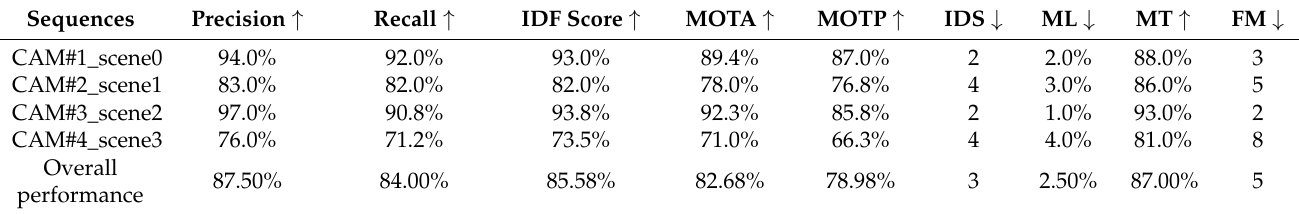
Table 3. Performance evaluation metrics on EPFL dataset passageway